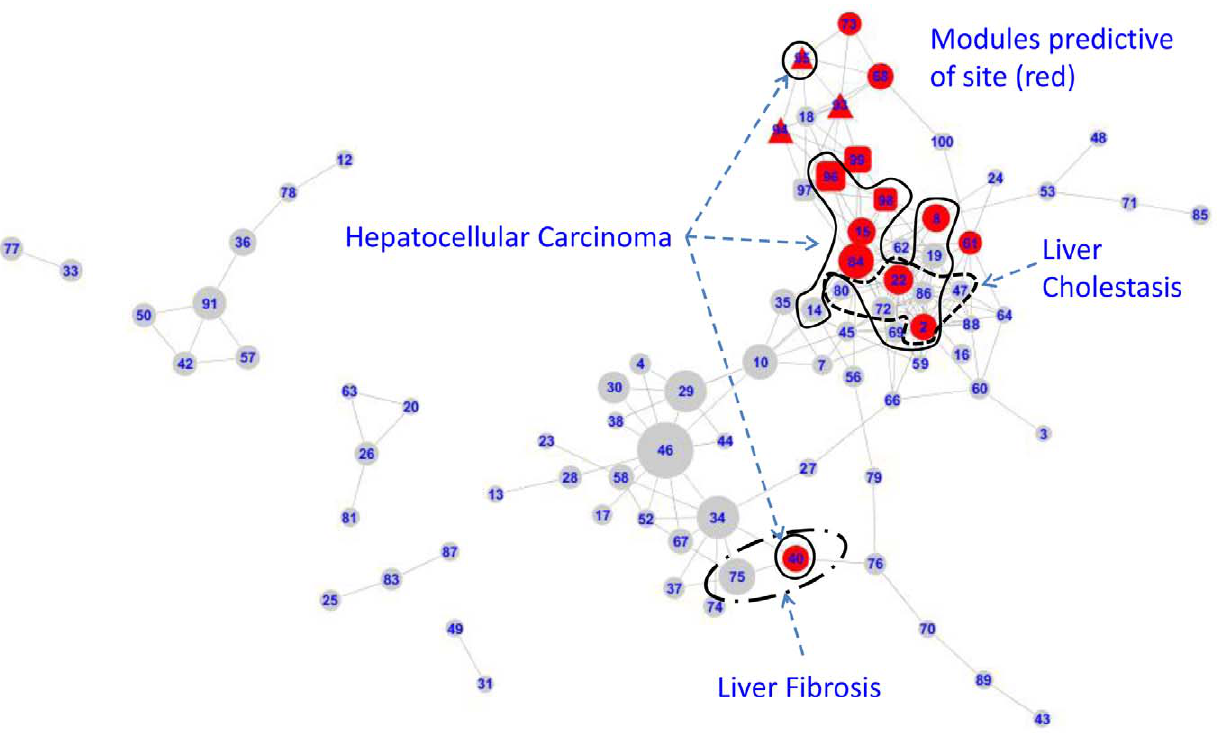
Figure 5. Modules associated with mammalian hepatotoxicity annotation. Modules predictive of sampling site are shown in red. Those associated with hepatocellular carcinoma are indicated by a solid line, those associated with liver cholestasis and liver fibrosis are indicated by dashed lines. Annotation terms were derived from Ingenuity.